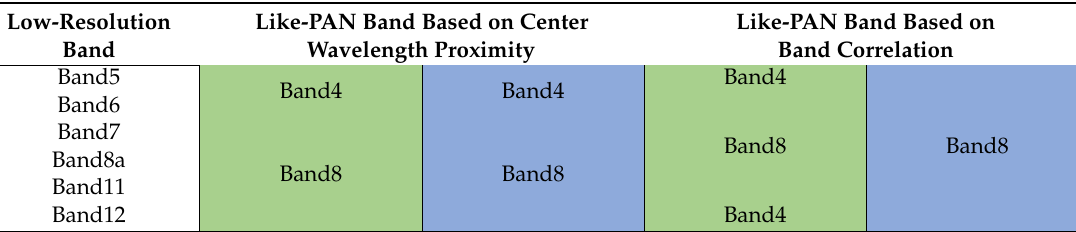
Table 2. The optimal PAN-like bands for each 20-m band determined by center wavelength proximity and bands correlation of Sentinel-2 (two image tiles were distinguished by colors).